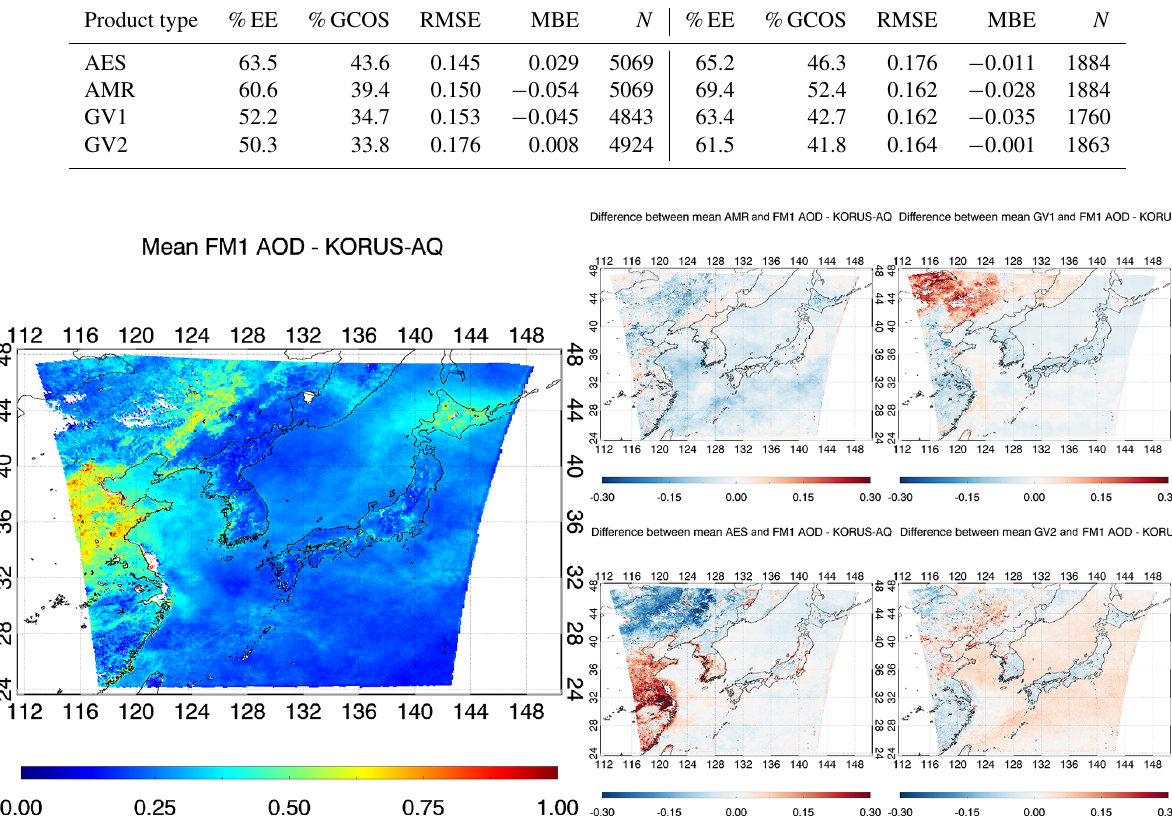
Figure 4. The average AOD of (a) FM1 (AMR, AES, GV1, and GV2) during the KORUS-AQ. The difference of mean (b) AMR, (c) AES, (d) GV1, and (e) GV2 AODs with respect to mean representative (FM1) AOD. Figures generated with Interactive Data Language (IDL) version